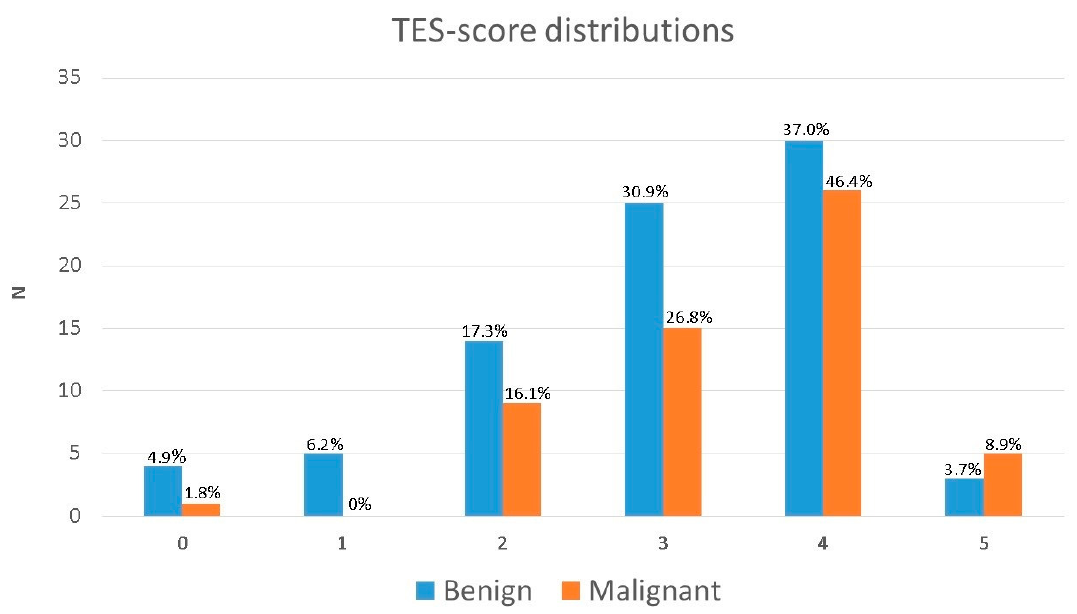
Figure 5. Distribution of TES-scores for benign and malignant tumors, respectively.